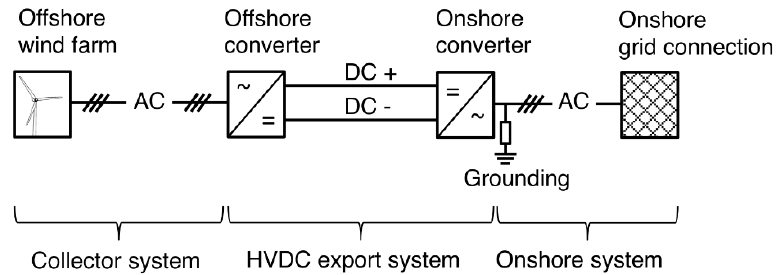
Figure 1. Schematic configuration of the offshore wind farm and the high-voltage direct current (HVDC) energy export system.